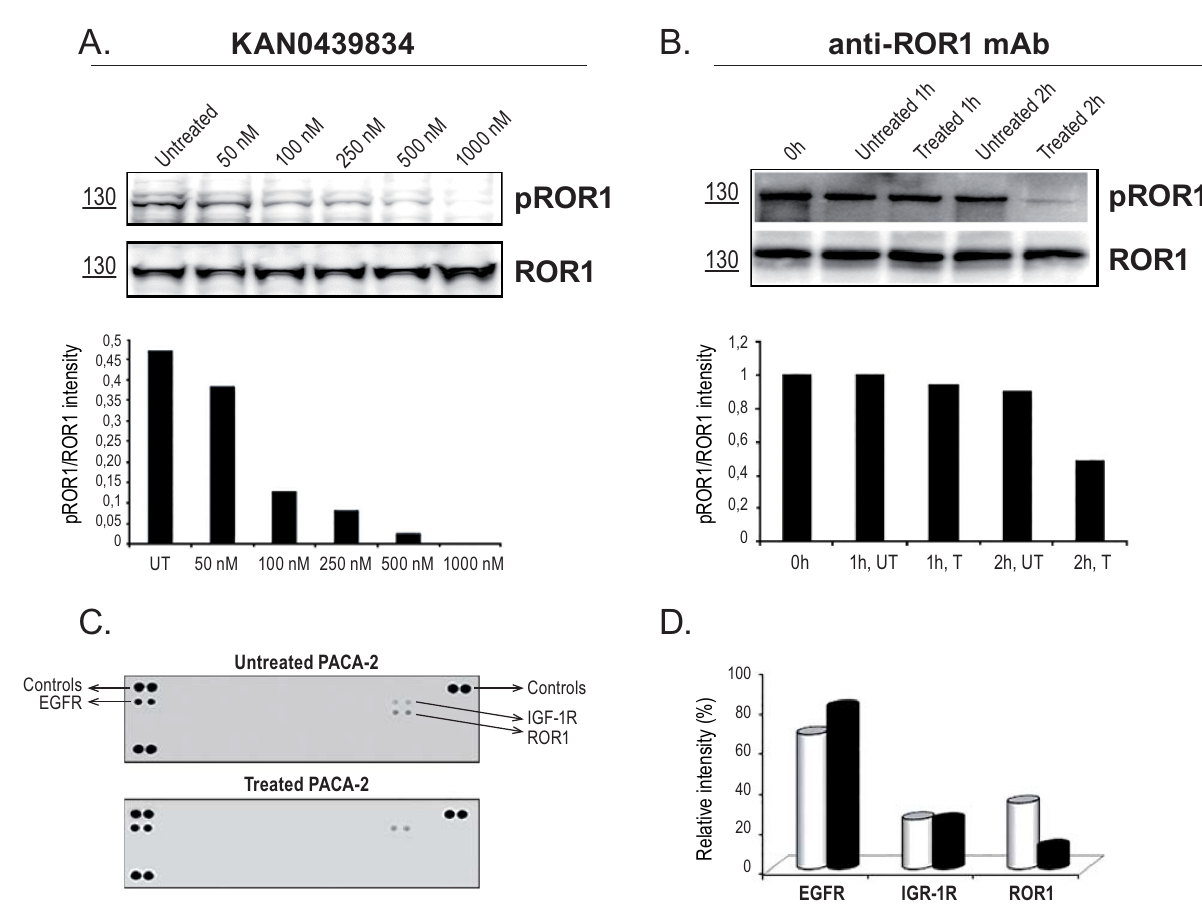
Fig 7. KAN0439834 and anti-ROR1 mAb inhibited ROR1 phosphorylation in pancreatic carcinoma cells (PaCa-2). Total ROR1 (ROR1) and phosphorylated ROR1 (pROR1) after 2 h incubation with KAN439834 (A) and (B) anti-ROR1 mAb. Intensity values of pROR1 relative to total ROR1 are shown. Effects on phosphorylation of RTKs (Phospho-RTK array) in PaCa-2 cells by KAN0439834. (C) PaCa-2 cells were treated with 500 nM of KAN0439834 for 2 h (( & ) or untreated (UT) for 2 h ( & )). EGFR, ROR1 and IGF-1R were detected in this specific array. Inhibition of ROR1 phosphorylation could only be noted after exposure to KAN0439834. (D) Relative intensity values of pEGFR, pIGF-1R and pROR1 to total EGFR, IGF-1R and